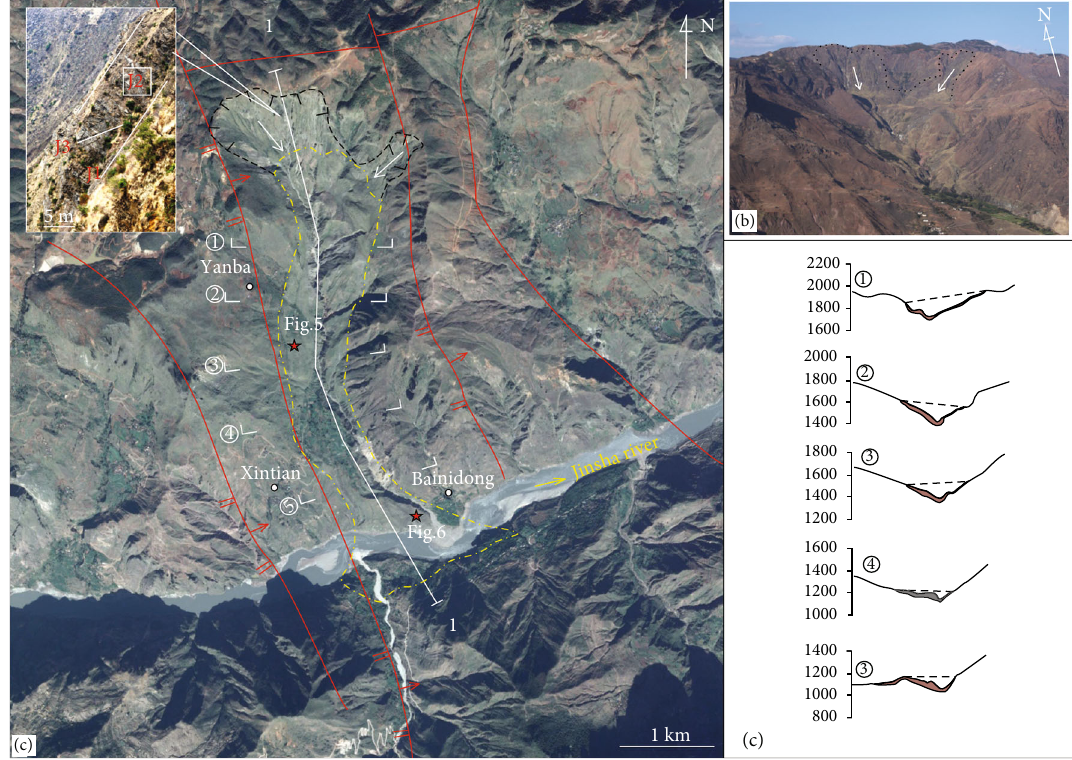
Figure 2: Remote sensing image of LRA and the cross section along the ditch (Google satellite image,